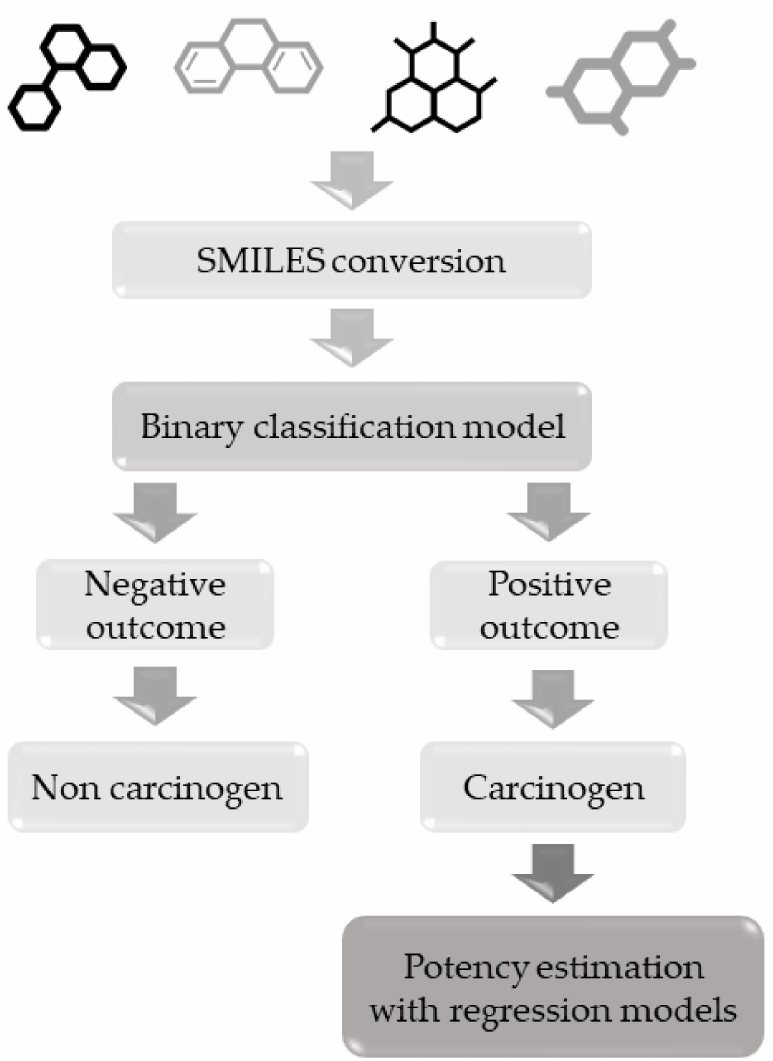
Figure 1. Hierarchical workflow to apply classification and regression-based models for